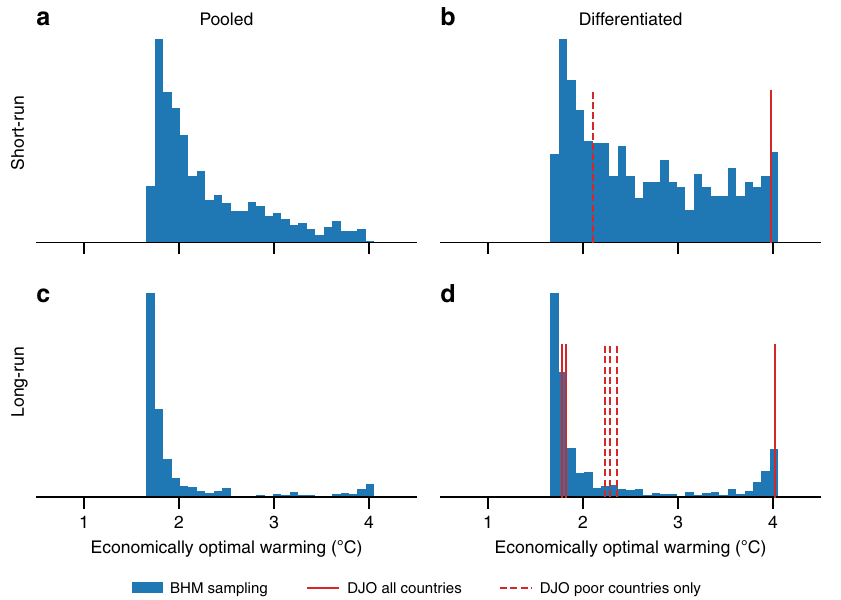
Fig. 4 Ensembles including the uncertainty in the estimates of the historical impacts according to BHM (blue bars) and some samples according to Dell et al. 4 (DJO, red lines). Speci fi cation of the estimates without (short-run ( a , b )) and with (long-run ( c , d )) the assumption that the in fl uence of warming on economic growth is lagged and/or without (pooled ( a , c )) and with (differentiated ( b , d )) differentiating between impacts on poor and on rich countries. Each speci fi cation for BHM samples from 1000 bootstraps of the historical regression; samples for DJO include speci fi cations with no lag ( b ) as well as 1-lag, 5-lag, and 10-lag speci fi cations ( d